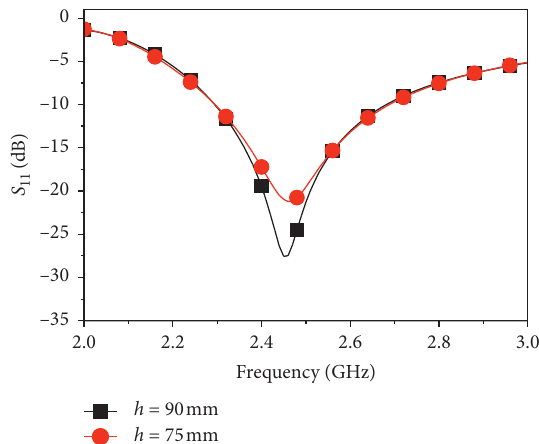
Figure 3: Comparison of the reflection coefficients.